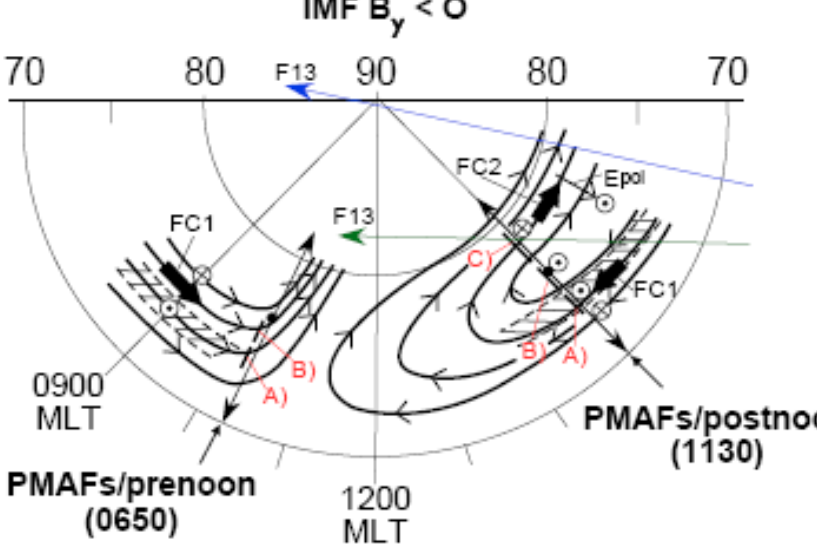
Fig. 1. Auroral forms in relation to plasma convection streamlines associated with dusk-centered and dawn-centered convection cells in MLT/MLAT coordinates for B y negative conditions. Fields-of-view of the Ny ˚Alesund meridian scanning photometer (MSP) are marked for 06:50 UT (16 December 1998) and 11:30 UT (30 November 1997). Substructure of PMAFs/prenoon and PMAFs/postnoon are indicated by labels A, B, and C. Dusk-dawn passes of spacecraft DMSP F13 on 30 November 1997 and 21 January 2001 are marked by green and blue arrowed lines, respectively. Birkeland current patterns are indicated along the 09:00 and 15:00 MLT meridians.